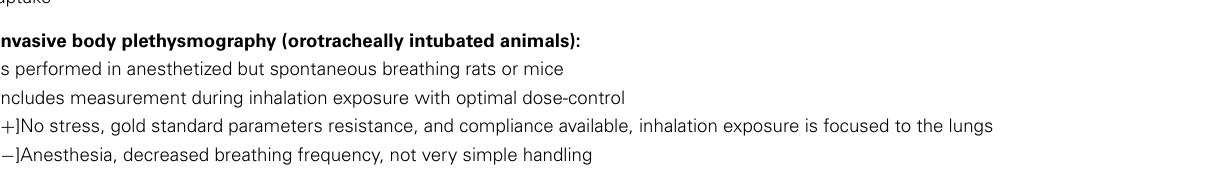
seven and females on PND 21 and 45: n = 7). Closed symbols represent male animals ( (cid:7) ) and open symbols represent female animals ( [reprinted with permission from Lewin et al. (2010)]; see there for additional data).